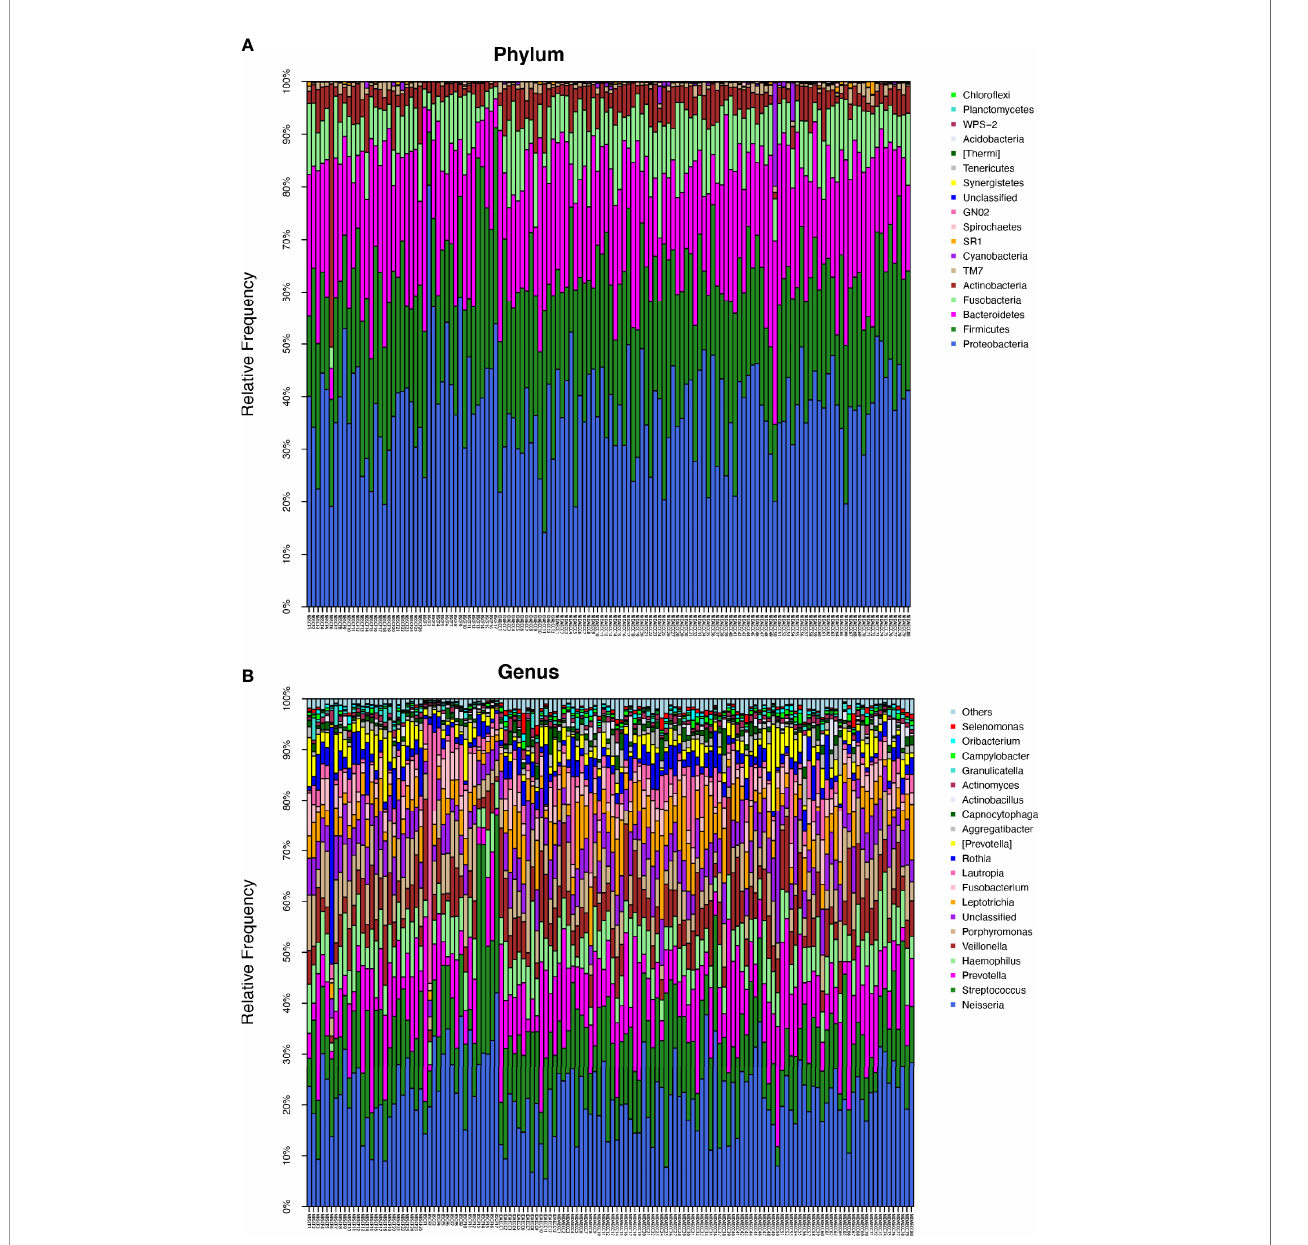
FIGURE 1 | (A) The composition of phyla with ECC (including IDA ECC and NIDA ECC) and CF (including BSCF and NBSCF). Bar plot of percentage abundance at the phylum level in every sample. The horizontal axis is the name of each sample. They are ECC (including IDA ECC 1-13 and NIDA ECC 1-80) and CF (including BSCF 1-17 and NBSCF 1-26). (B) The composition of genera with ECC (including IDA ECC and NIDA ECC) and CF (including BSCF and NBSCF). Bar plot of percentage abundance at the genus level in every sample. The horizontal axis is the name of each sample. They are ECC (including IDA ECC 1-13 and NIDA ECC 1- 80) and CF (including BSCF 1-17 and NBSCF